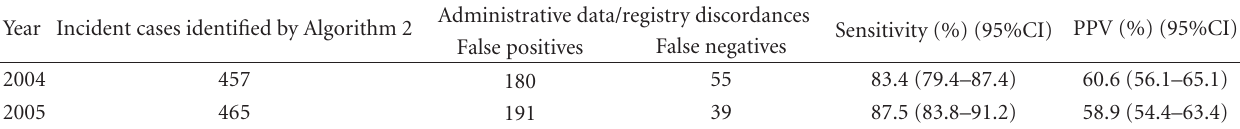
Table 3: Algorithm 2 results in Cˆote d’Or by diagnostic year: sensitivity and positive predictive value of administrative data for identifying incident colorectal-cancer cases versus cancer registries used as the gold standard.